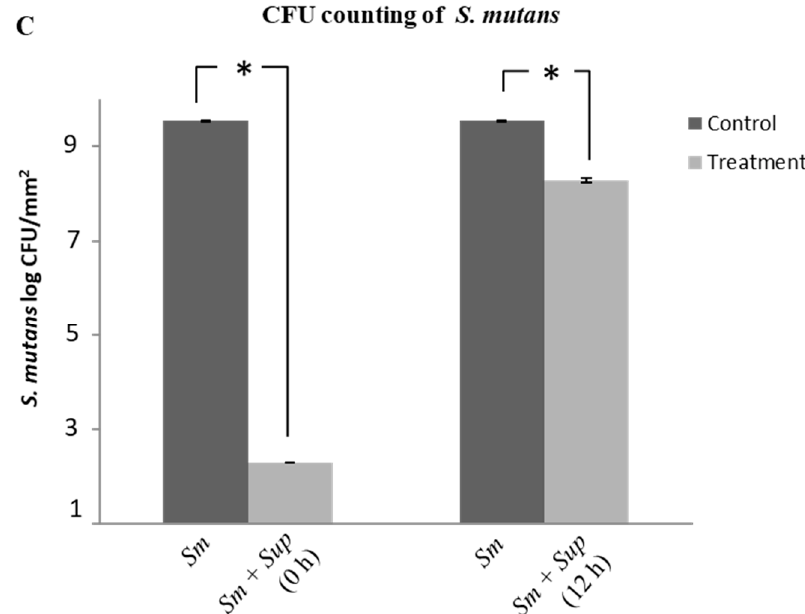
Figure 2. Lactobacillus plantarum 108 supernatant (Sup) inhibited S. mutans (Sm) biofilm formation and demonstrated activity against preformed biofilms. Lp108 supernatant was introduced at two time points; 0 h for the preventive assay and at 12 h into a preformed biofilm for the therapeutic assay. Biofilms were quantified using ( A ) XTT reduction assay, ( B ) Crystal Violet assay and ( C ) Colony forming unit counting (CFU). Data are presented as mean ± SD and statistical significance indicated by the asterisk (*) was evaluated with respect to the control group without the Lp108 supernatant treatment ( p < 0.05).